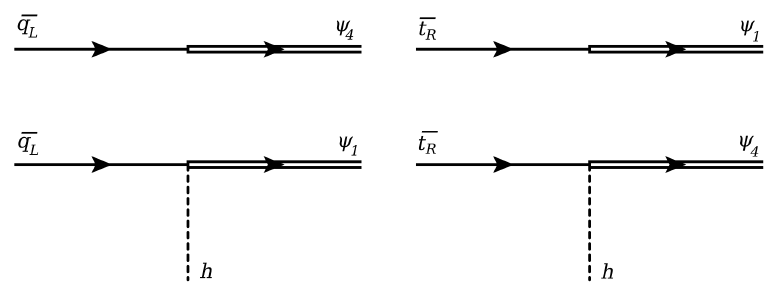
Figure 1 . Fermion vertices derived assuming the partially composite interactions in L int